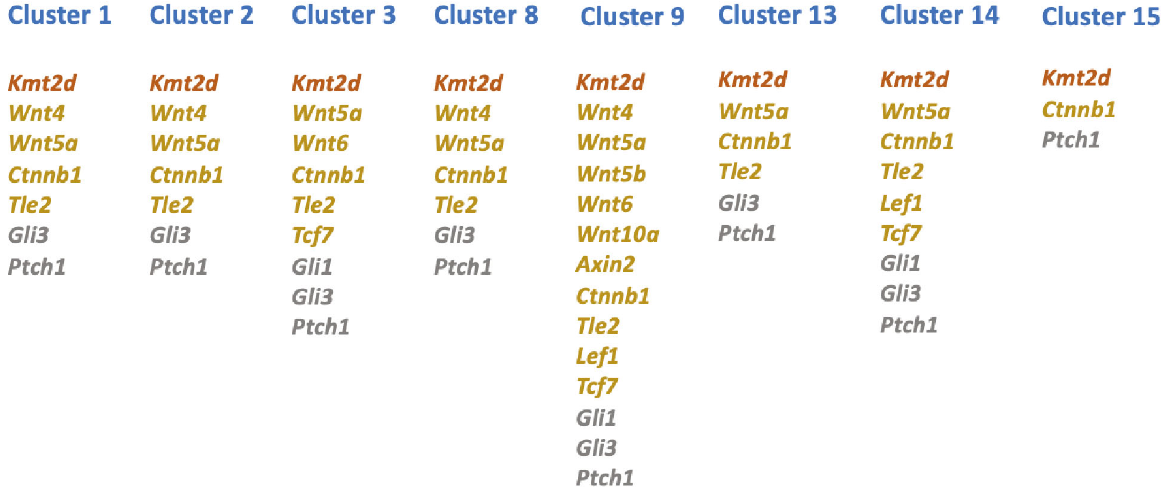
Figure 7: Core set of genes that are common in fi ve subpopulations of MSCs. These genes are Wnt5a , Ctnnb1 , Tle2 , Gli3 , and Ptch1 . Kmt2d is marked in brown. Members of the WNT signaling pathway are shown in light brown and members of SHH signaling are in